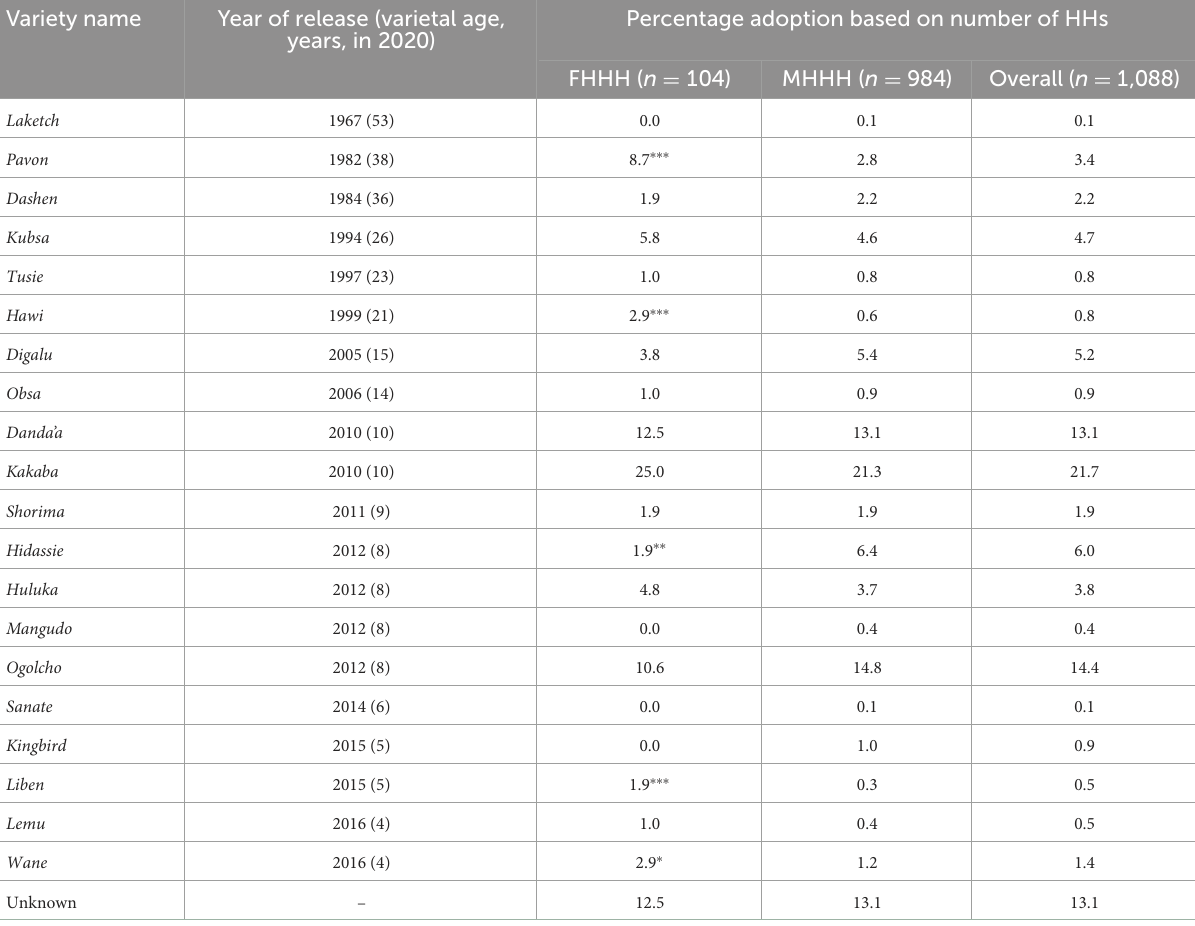
TABLE 2 Wheat varieties grown by sample households in the 2020/2021 main cropping